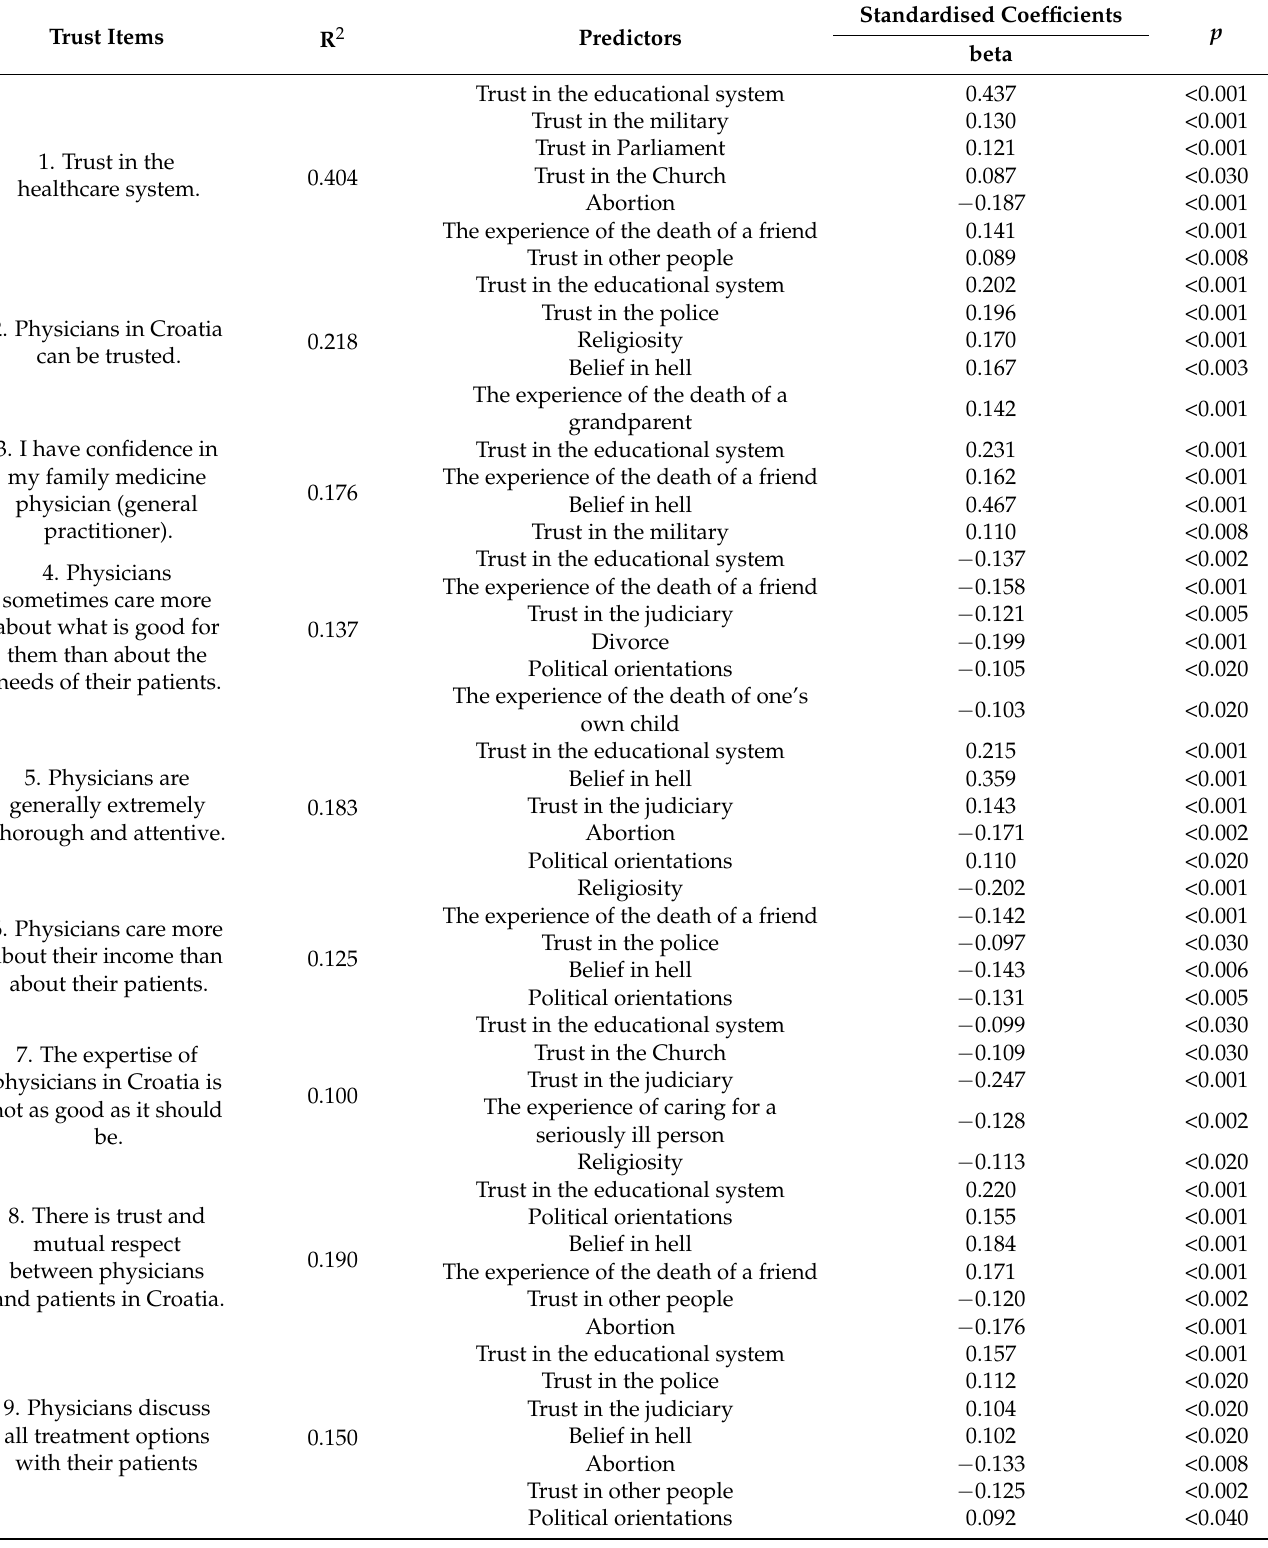
Table 6. Results of multiple regression analysis—predictors of trust in healthcare, physicians, and specific dimensions of the physician–patient